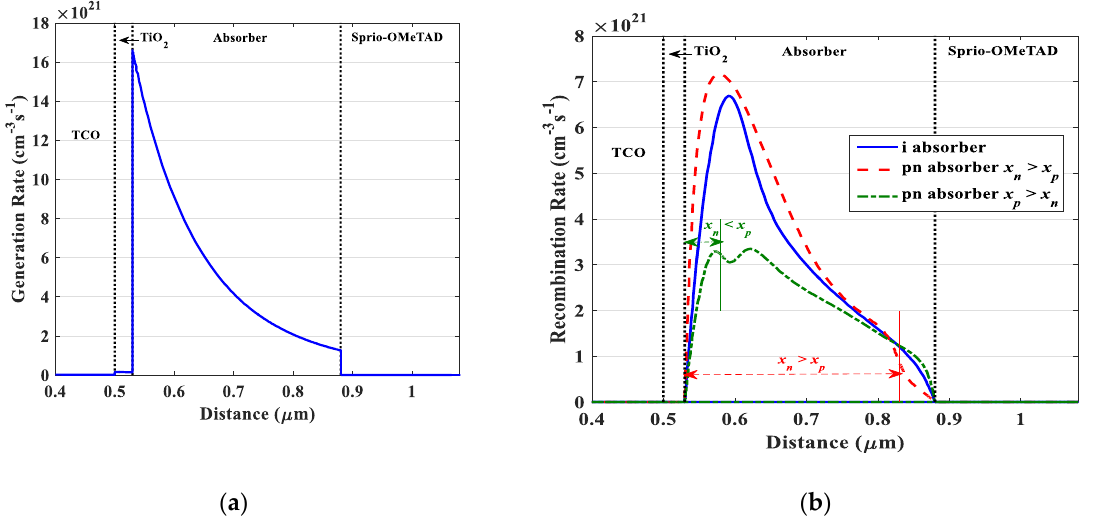
Figure 6. ( a ) The generation rate and ( b ) recombination rate across the device distance at a voltage of 0.5 V for three distinctive cases of absorber.